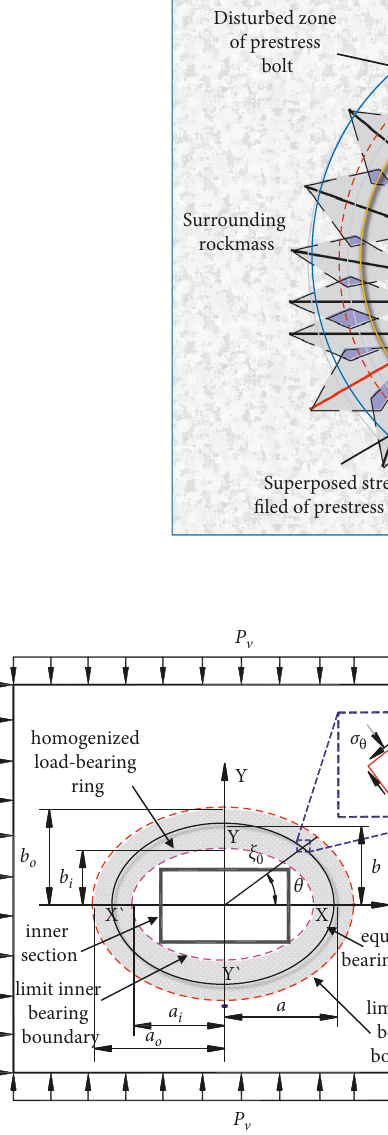
Figure 2: Mechanical model of simplified load-bearing ring in roadway surrounding rock